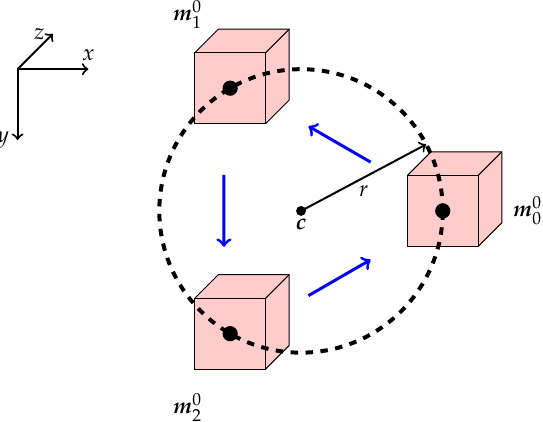
Figure 3. We define, in this example, N = 3 templates by moving the OCT’s FOV (red) to three positions m 0 on a circle with radius r . The initial circle lies within a plane parallel to the xy -plane, i but during tracking this might change due to rotational motion.